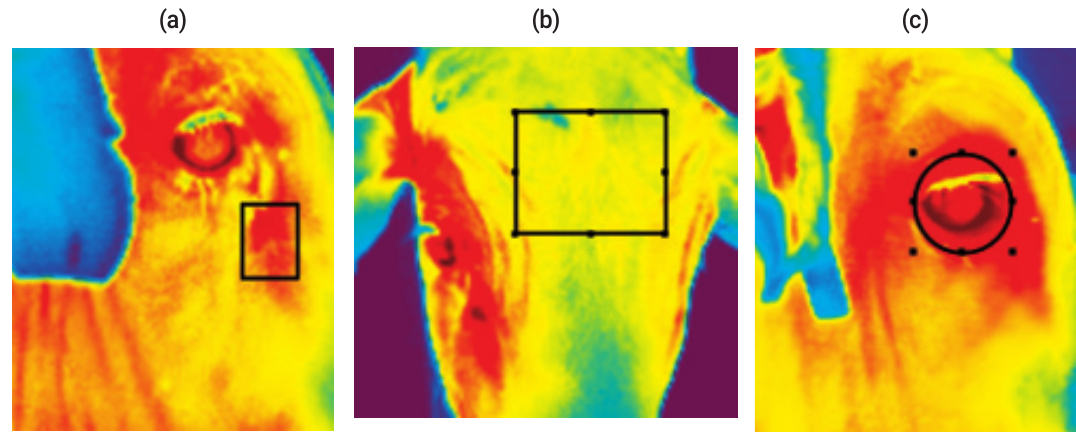
Figure 1. Infrared thermography images showing the sub-area of the body where the images were obtained: (a) cheek, (b) front, (c) ocular area.